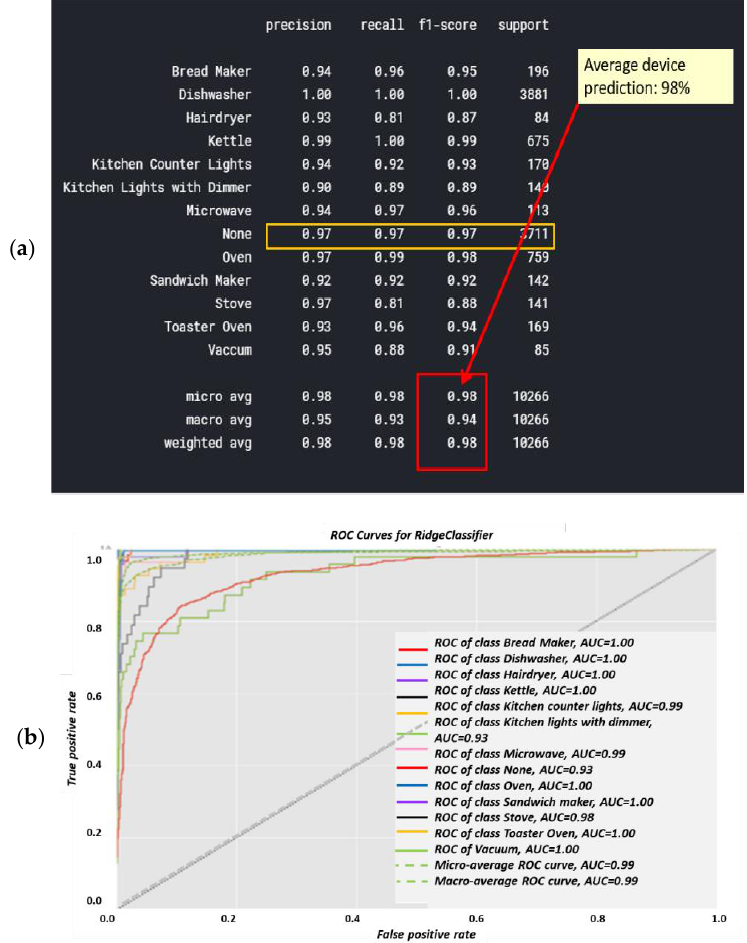
Figure 12. Ridge ( a ) classification report and ( b ) AUC-ROC curves for each of the 13 electrical de-vices.